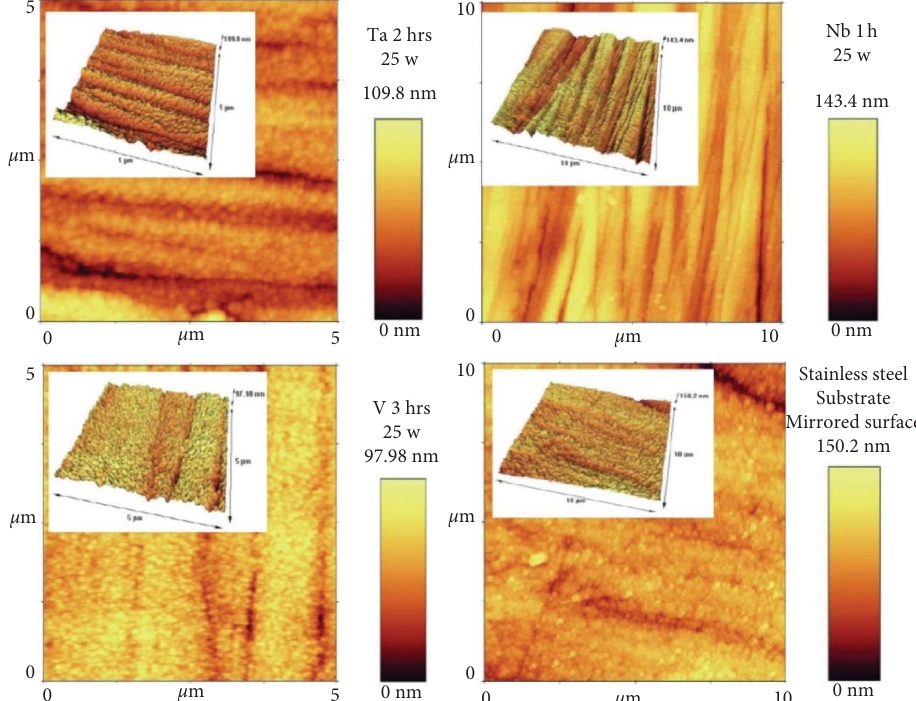
Figure 10: Comparison of 2D and 3D AFM topographical images of some specimen groups and untreated mirrored surfaces of 316L SS substrates. Table 6: Comparison of surface roughness of all coated specimens at 1, 2, and 3 hours using the one-way ANOVA test. F Sig Nb 0.257 0.781 Te mean diference is signifcant at the 0.05 level. Table 7: Independent t -test between each coated group and un- coated 316L SS substrates. N Mean (nm) Std. deviation